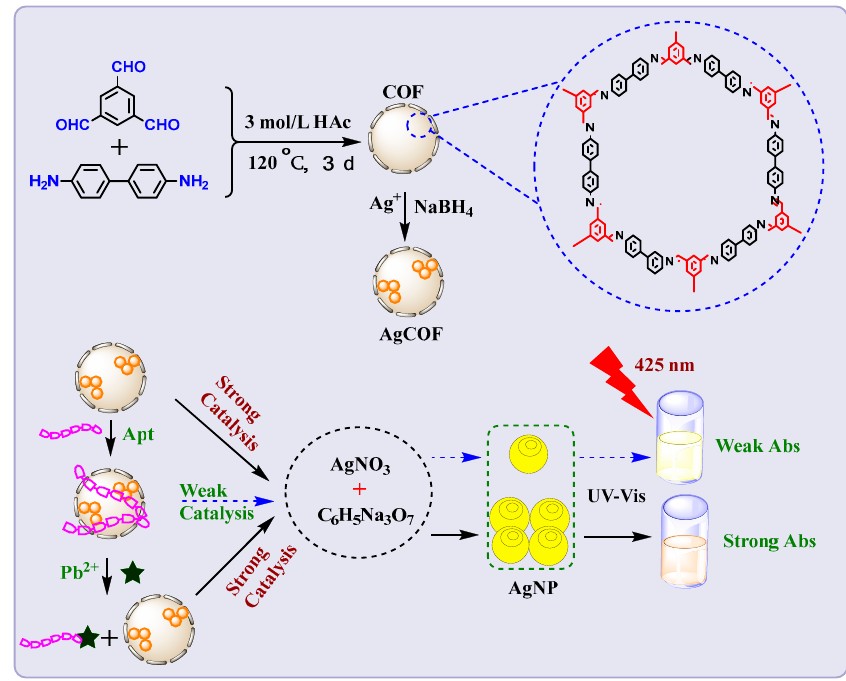
Figure 1. Schematic diagram of the preparation of AgCOF and its catalytic amplified colorimetric determination of Pb 2+. determination of Pb